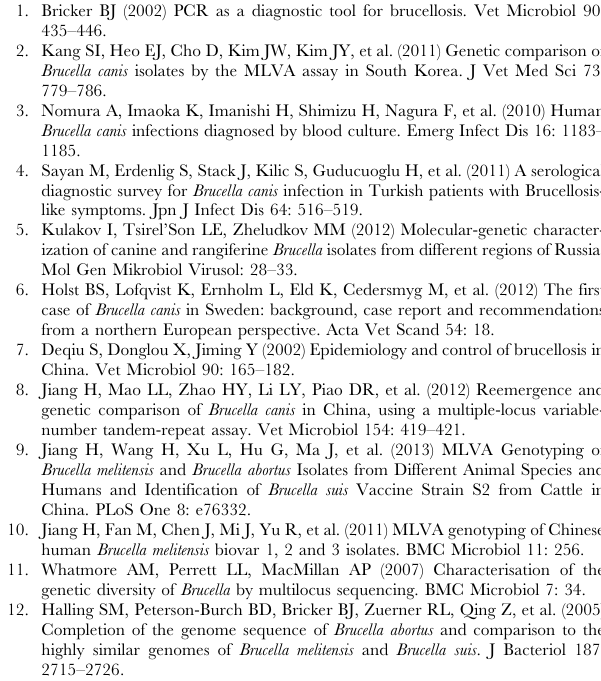
Table S1 MLVA-16 genotypes for 67 B. canis strains. (XLS)